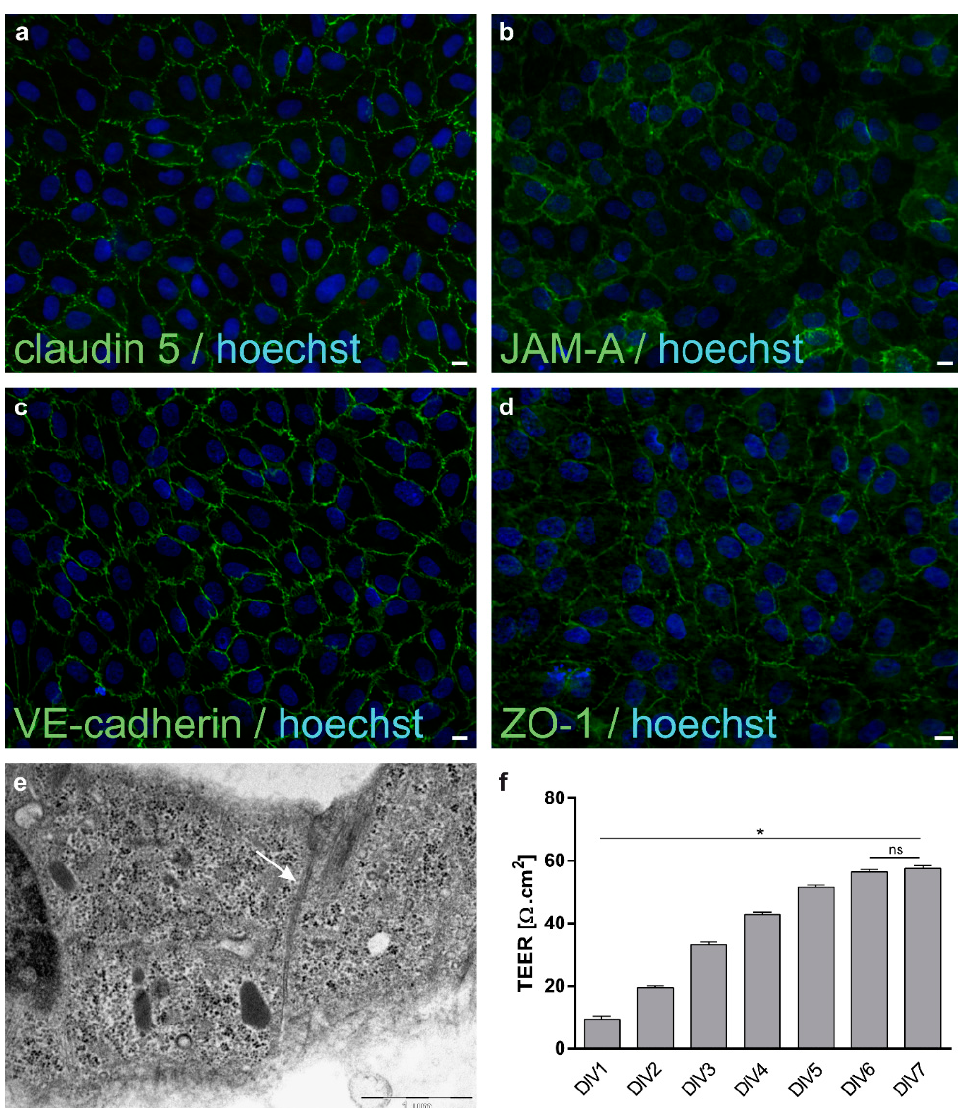
Figure A4. Barrier formation by means of cellular junctions and transendothelial electrical resistance (TEER) in hBLECs. Representative microscopic images show continuous expression of different tight and adherens junction markers (green) such as claudin 5 ( a ), JAM ‐ A ( b ), VE ‐ cadherin ( c ) and ZO ‐ 1 ( d ). Scale bars: 10 μ m. Cell nuclei were counterstained with Hoechst (blue). Establishment of tight and adherens junctions was further confirmed by TEM (e; white arrow, scale bar: 1 μ m). Increases in TEER values over the duration of the co ‐ culture period also indicate formation of a barrier ( f ). DIV = day in vitro. Error bars represent SEM. Significant differences between DIVs are labeled with an asterisk (*) (* = p ≤ 0.0001), ns = not significant.